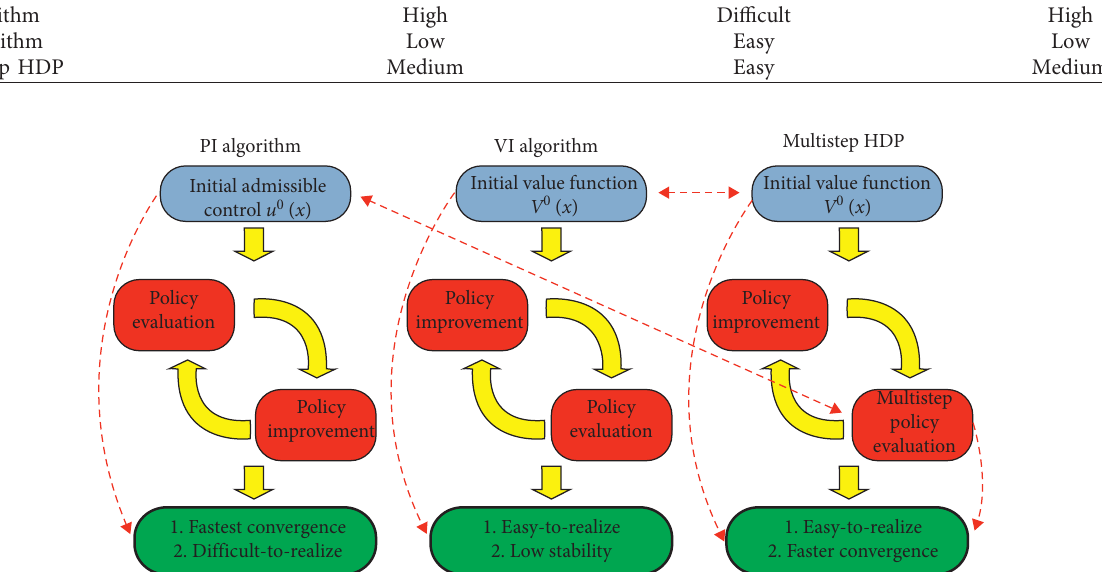
Table 1: Performance comparison among PI algorithm, VI algorithm, and multistep HDP. Methods and